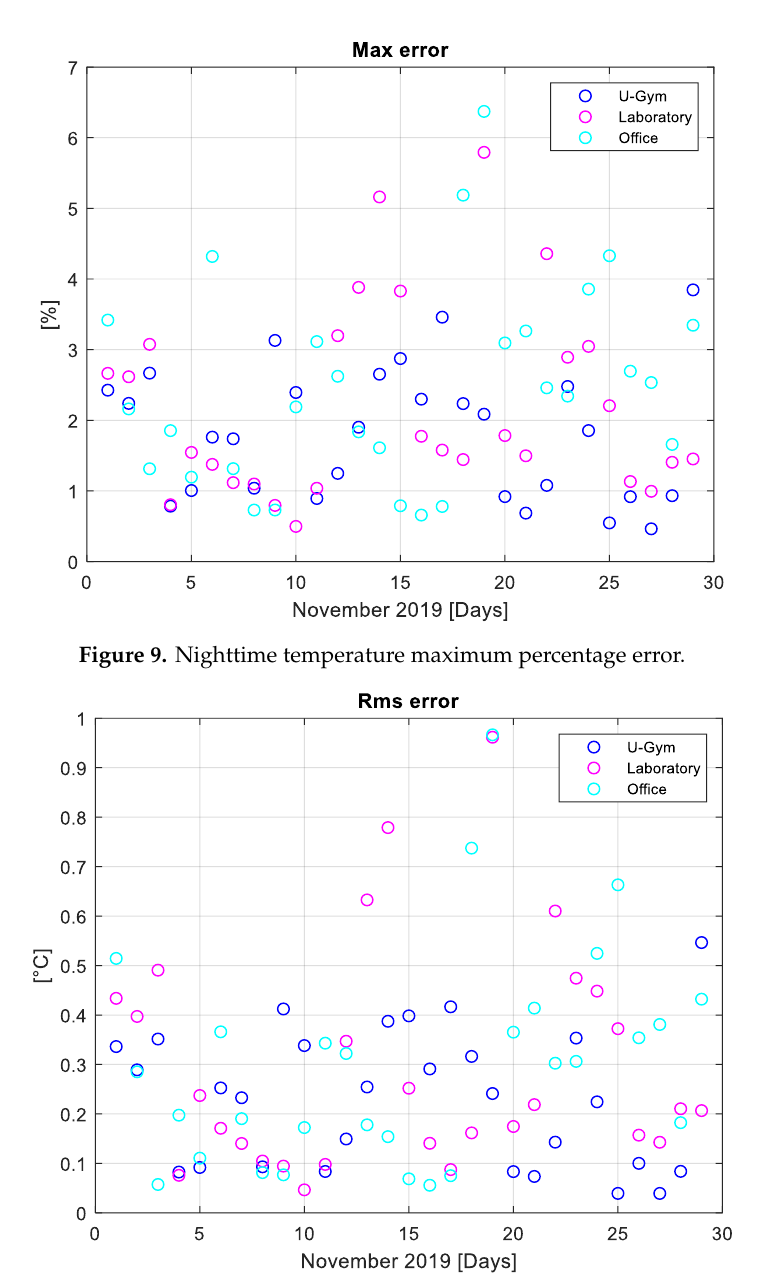
Figure 10. Nighttime temperature root mean square error. Table 1. Discomfort indicator